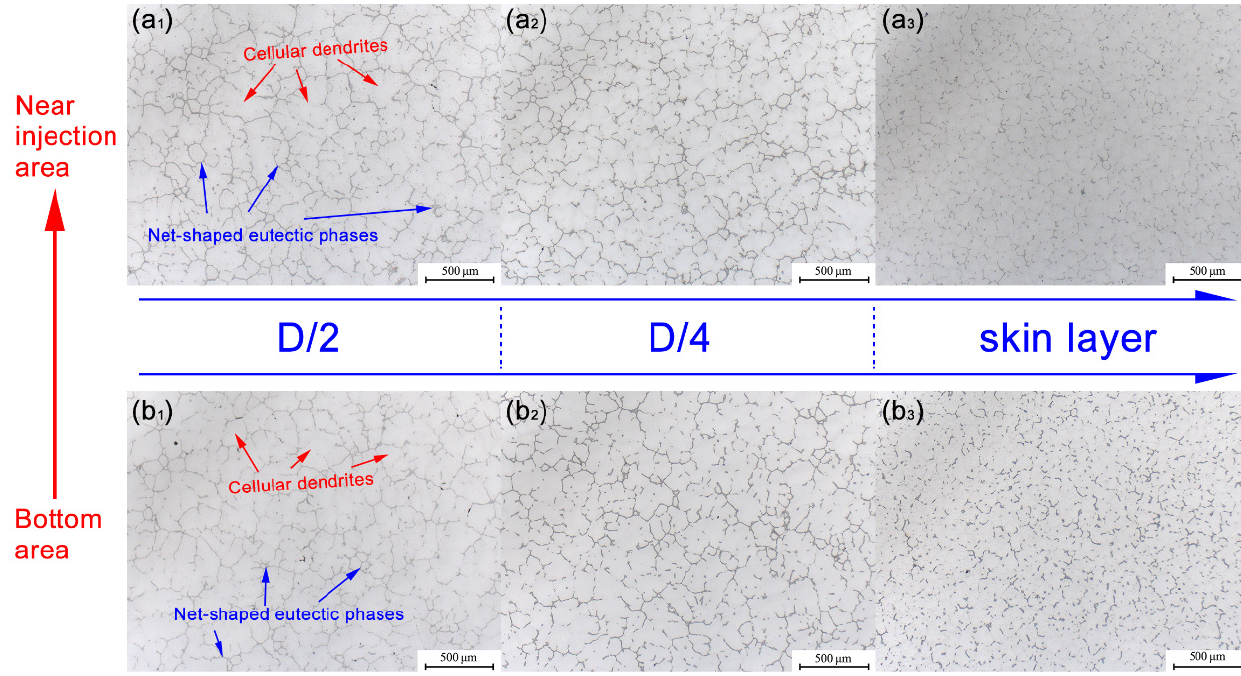
Figure 2. Metallographic microstructure of the as-cast Al-Cu-Mg-Ag alloy, respectively, corresponding to the D/2 ( a 1 ), D/4 ( a 2 ), and skin layer ( a 3 ) positions of the near injection area and the D/2 ( b 1 ), D/4 ( b 2 ), and skin layer ( b 3 ) positions of the bottom area.